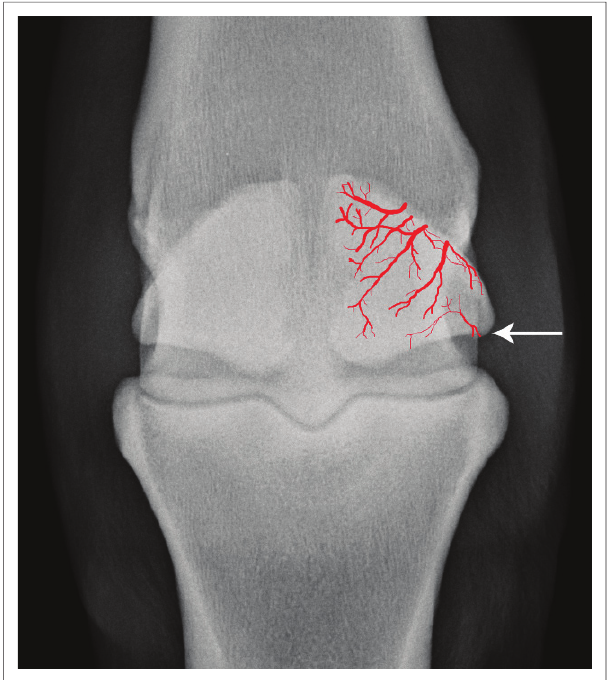
FIGURE 2: Dorsoproximal-palmarodistal oblique radiographs of the left metatarsophalangeal joint of a 6-year-old Friesian stallion, with a schematic representation of the blood supply to the proximal sesamoid bones superimposed on the